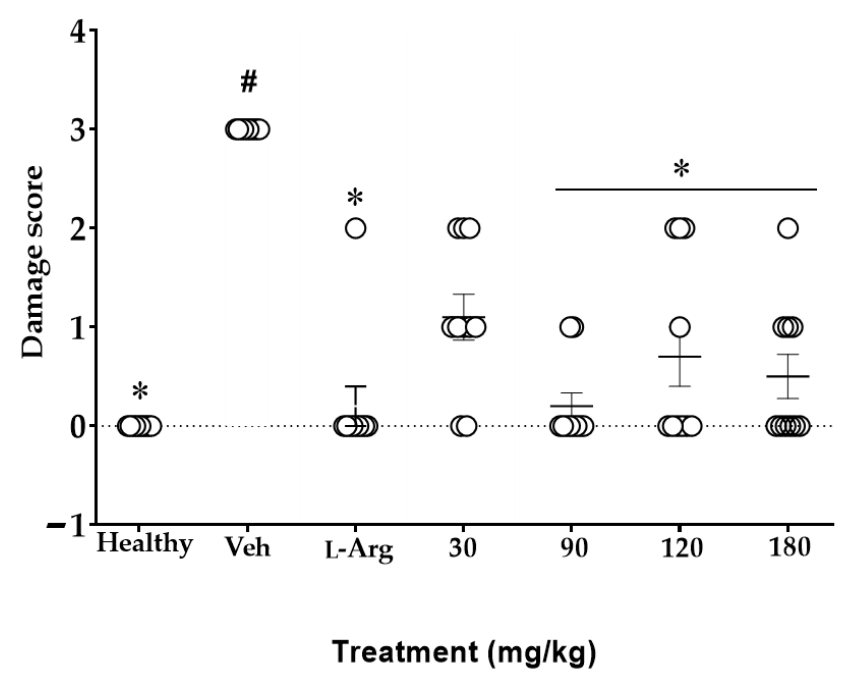
Figure 8. Effect of different doses of MaSS, the mixture of kaempferol 3- O -sophoroside and kaempferol 3- O -sambubioside, obtained from M. arboreus , on damage scores produced in the stomach of rats with ethanol. Healthy = rats without gastric lesions; L -Arg = amino acid L -arginine. Friedman was used with Dunn's multiple comparisons post -test (n = 5 ± ED, # p < 0.05 when groups are compared with the healthy group; * p < 0.05 compared with the Veh group).